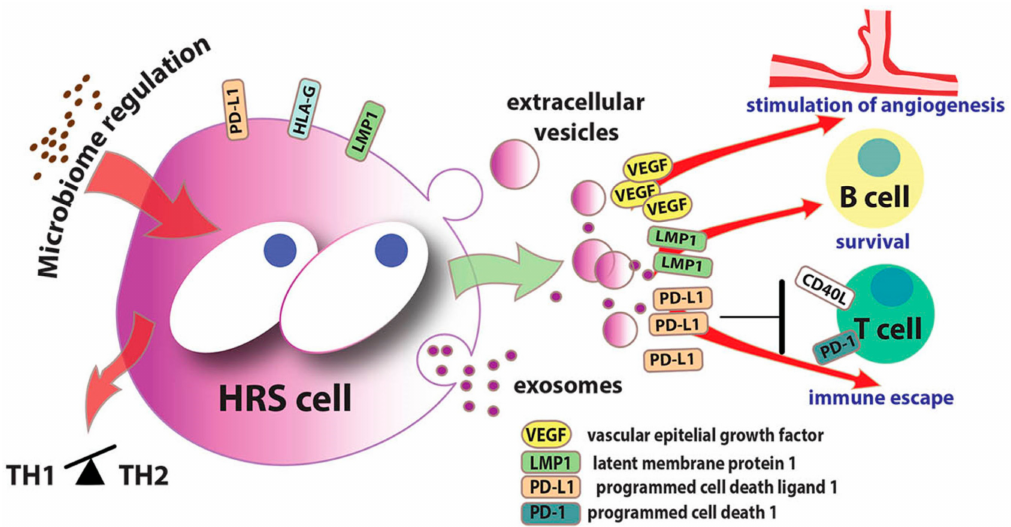
Figure 3. Interactions between the microbiome and Hodgkin Reed-Sternberg (HRS) cells and e ff ects of the release of extracellular vesicles / exosomes into the Hodgkin lymphoma (HL microenvironment. Intestinal microbiota has been suggested to play a role in HL development by acting on the host immune system, for instance type 1 T helper cells (Th1). Exosomes and extracellular vesicles from HL and Epstein-Barr virus (EBV)-positive HL exacerbate the worst phenotype of the tumor by remodeling the tumor microenvironment trough the delivery of Vascular Epithelial Growth Factor (VEGF, which promotes micro-vessel density), Latent Membrane Protein 1 (LMP1, which activates various molecular pathways including B-cell survival), while Programmed Cell Death Ligand 1 (PD-L1) trough binding of the Programmed Cell Death 1 (PD-1) receptor induces immunosuppressive function of the